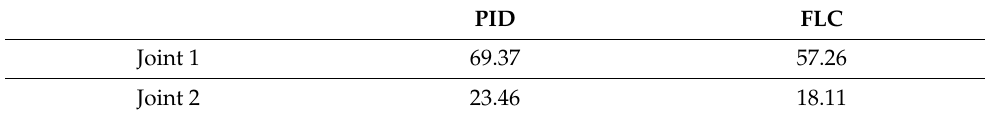
Table 8. IAE for both controllers: PID at the Edge Node and FLC at the Wireless